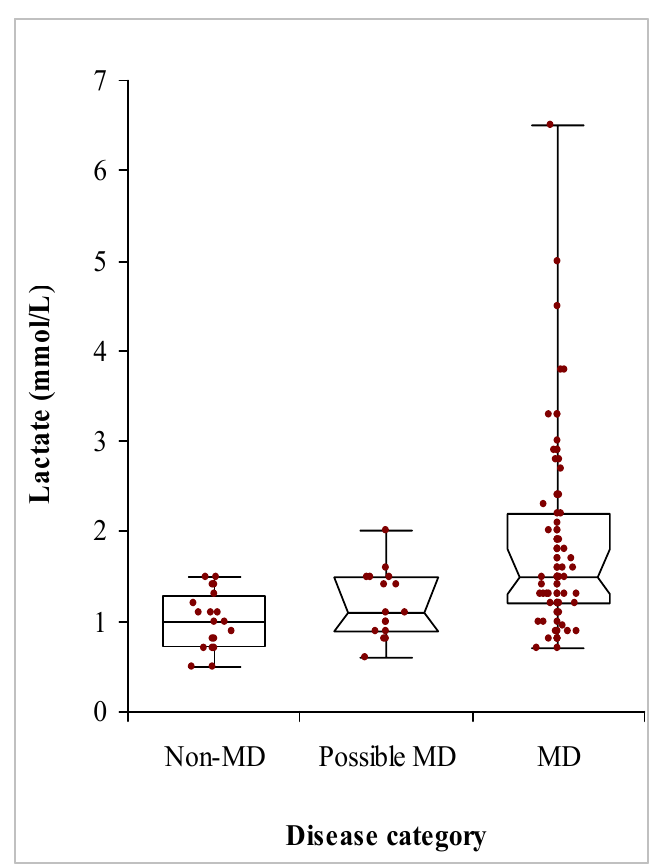
Figure 4. Distribution of plasma lactate concentrations in patients investigated for mitochondrial disease (MD). Patients were grouped according to the final diagnoses, with those who were likely to have MD by further investigations were still pending placed in the possible MD group.